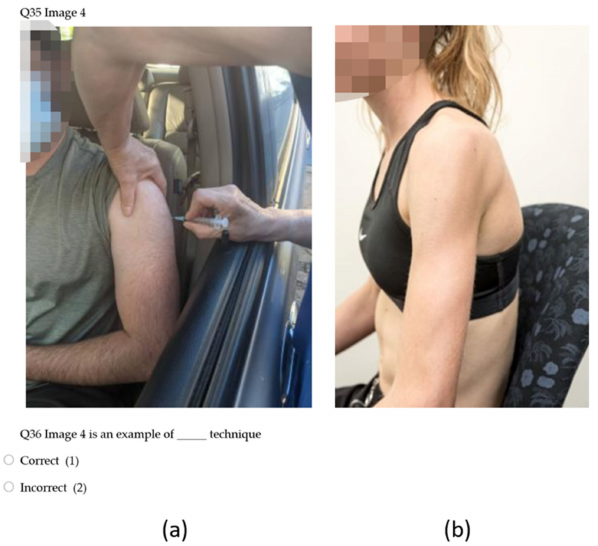
Figure 1. Image examples from Qualtrics ® questionnaire. Key: ( a ) Qualtrics question examining knowledge of safe injecting practices. ( b ) Standardised image of low body weight